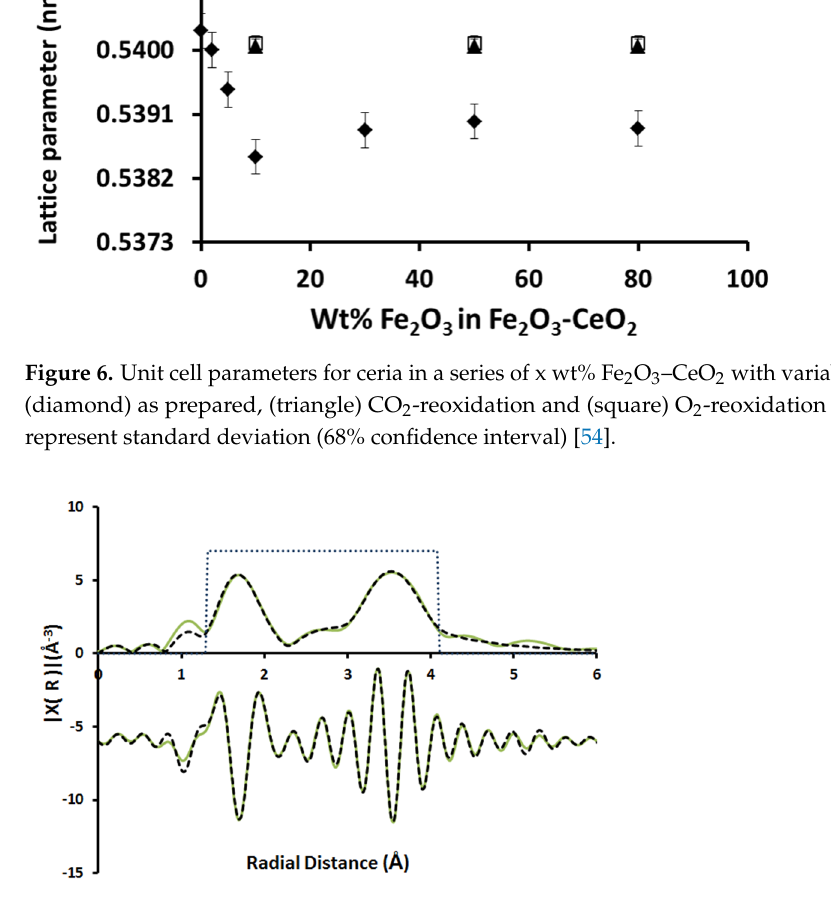
Figure 7. Fourier-transformed k 2 -weighted Ce-K edge Extended X-Ray Absorption Fine Structure (EXAFS) spectrum for 10 wt% Fe 2 O 3 -CeO 2 and modelling fit (dashed line), with an Fe incorporated CeO 2 model Ce 1 − x Fe x O 2 − x , wherein x = 0.21. Upper part: Fourier transforms (FT) modulus, lower part: imaginary Im[FT[k 2 χ (R)])]. Dotted rectangle: window fitting range. No phase correction was used. (-) EXAFS signal of 10 wt% Fe 2 O 3 –CeO 2 , (- - - -) fit and ( ···· ) fitting window